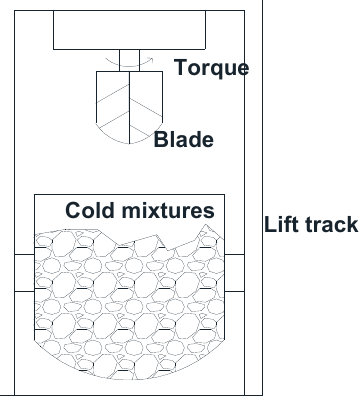
Figure 6. Principle of working string tester.